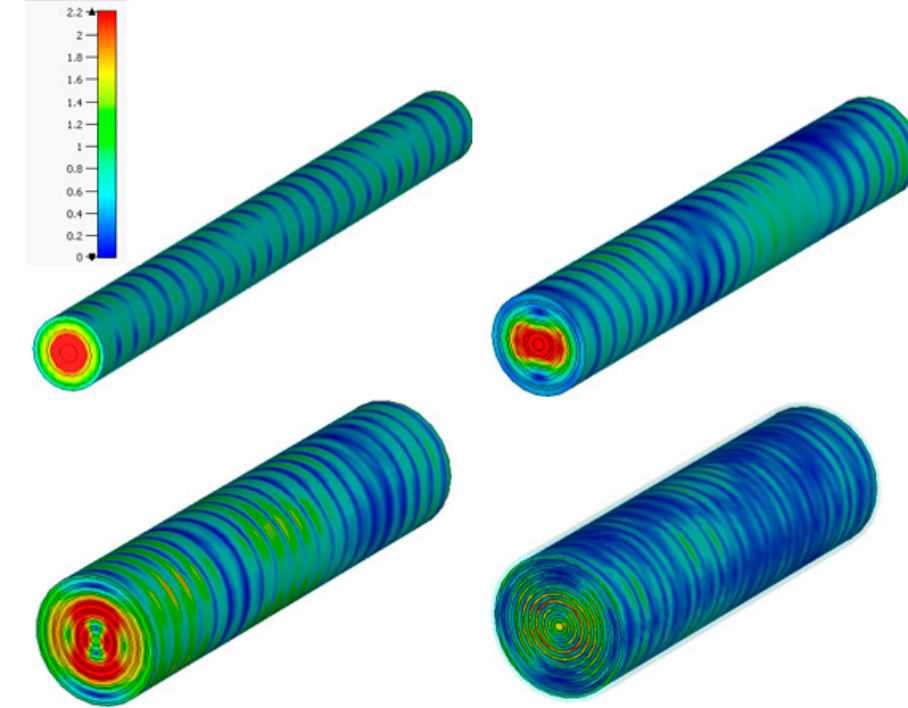
Figure 8. Electric field distribution inside dry poplar wood with different values of the number of growth rings with 100% permittivity variation at 3 GHz.